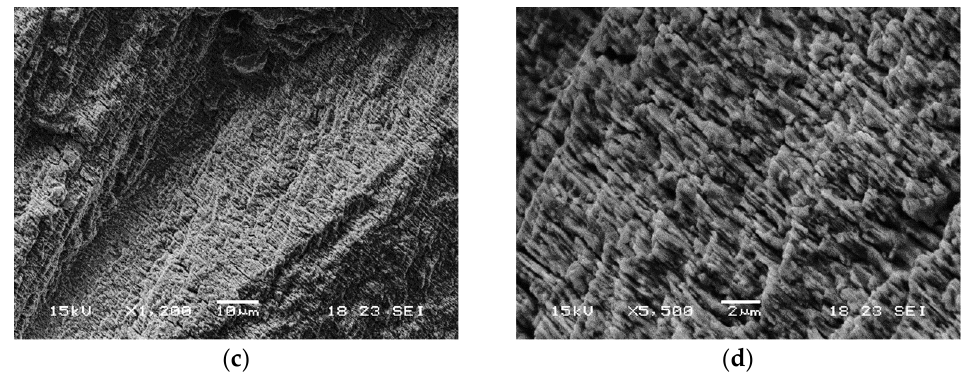
Figure 10. Fatigue fracture modes transition for the [110] crystallographic orientation: ( a ) macroscopic view in a confocal microscope; ( b ) typical ridgs at the second half of the fatigue crack, observed by SEM; ( c ) a facet at the crack initiation zone; ( d ) fatigue crack propagation in cleavage mode. The arrow indicates the fatigue crack propagation direction.